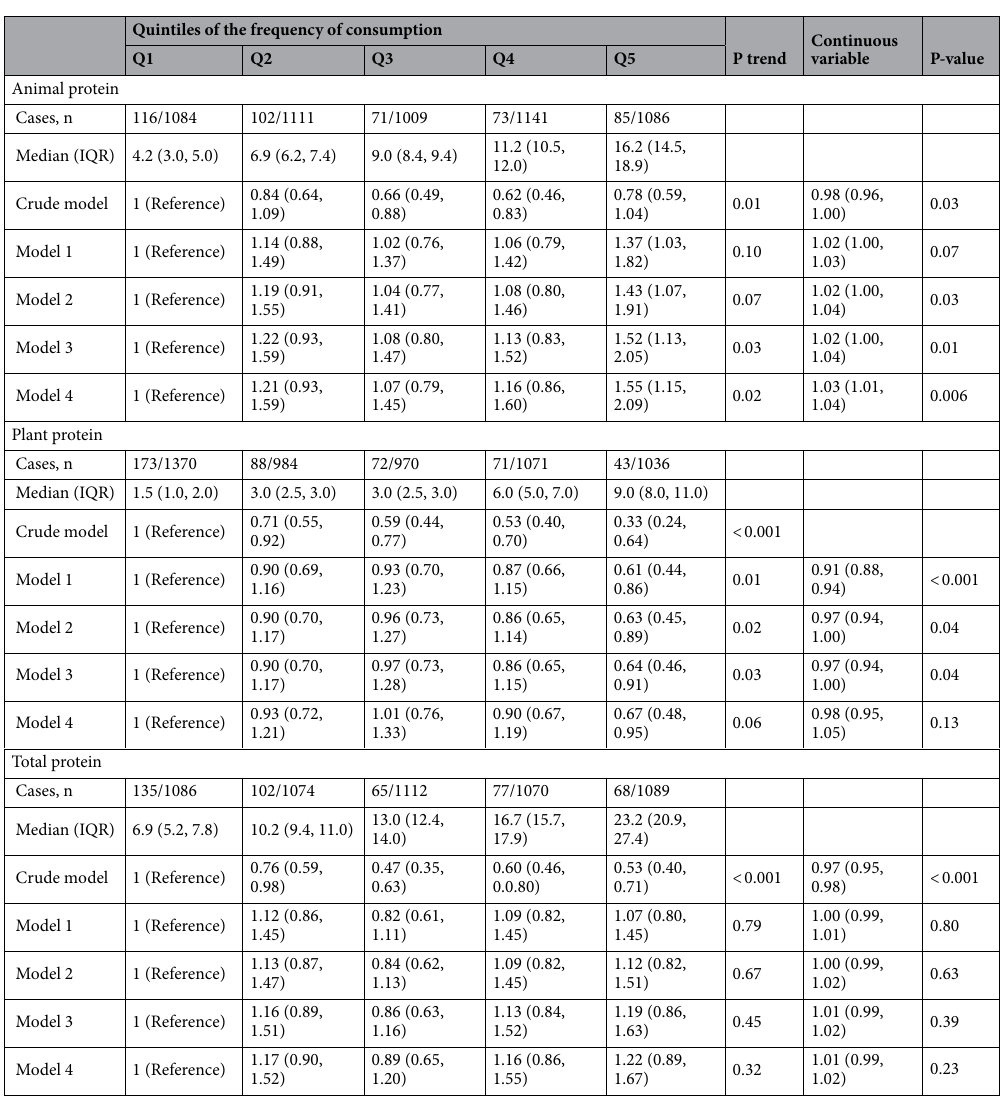
Table 3. Multivariate-adjusted HRs (95% CIs) of death according to quintiles of protein sources in the ICS. Model 1: HRs are adjusted for age (continuous) and sex. Model 2: Further control for education, smoking status, physical activity and body mass index was made. Model 3: Additionally adjusted for fruit and vegetables. Model 4: Additionally adjusted for hypertension, diabetes mellitus and